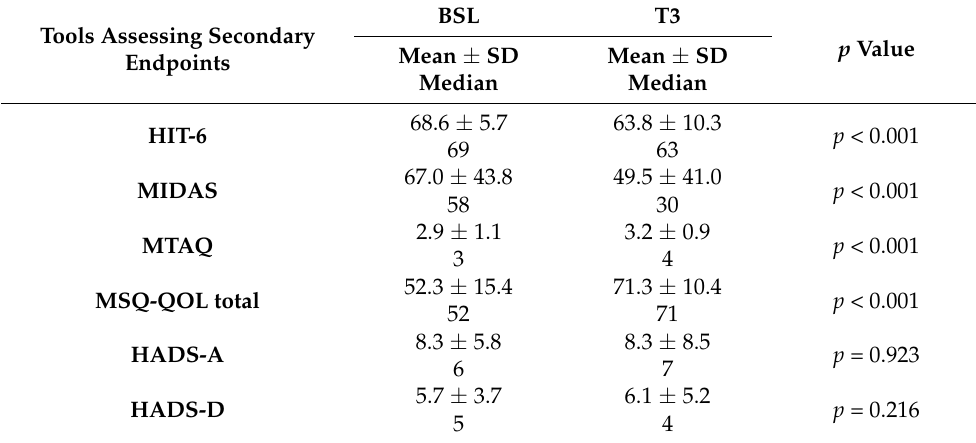
Table 2. Changes in outcome measures assessing secondary efficacy variables from baseline (BSL) to the last month of trimester (T3) of supplementation with in 113 patients comprising both the efficacy and intention to treat population. Tools Assessing